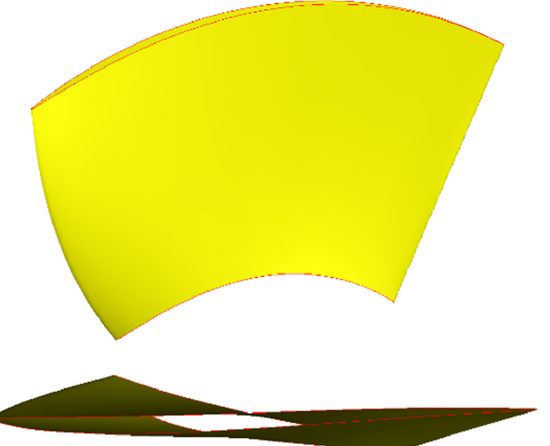
Figure 7. Model turbine runner blade of the semi-Kaplan turbine in an isometric view and shown from above.